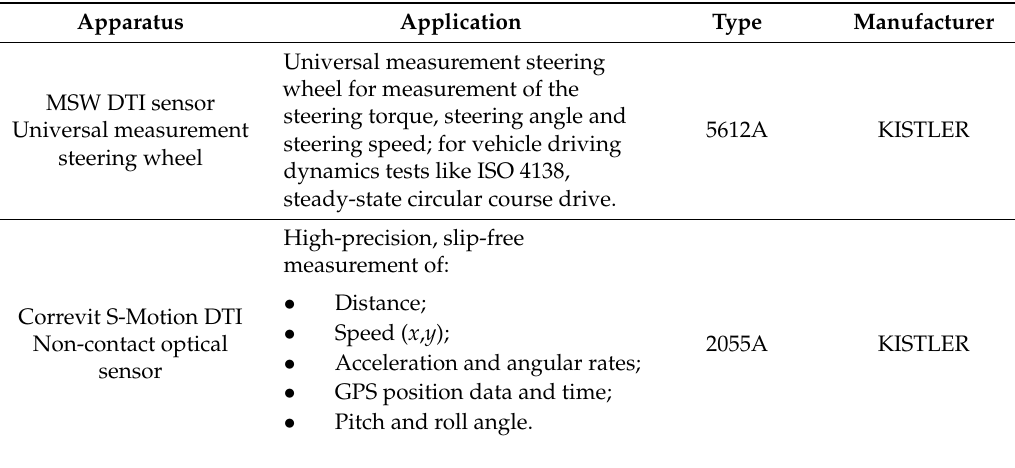
Table 3. Detailed information of main experimental apparatus.